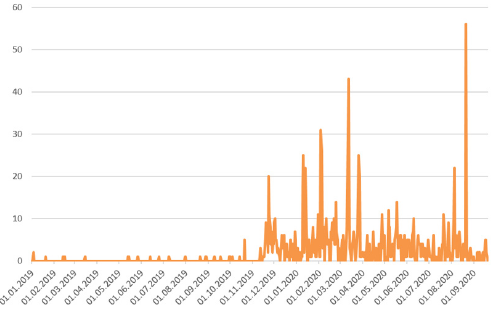
Figure 13. Dynamics of the negative message base.